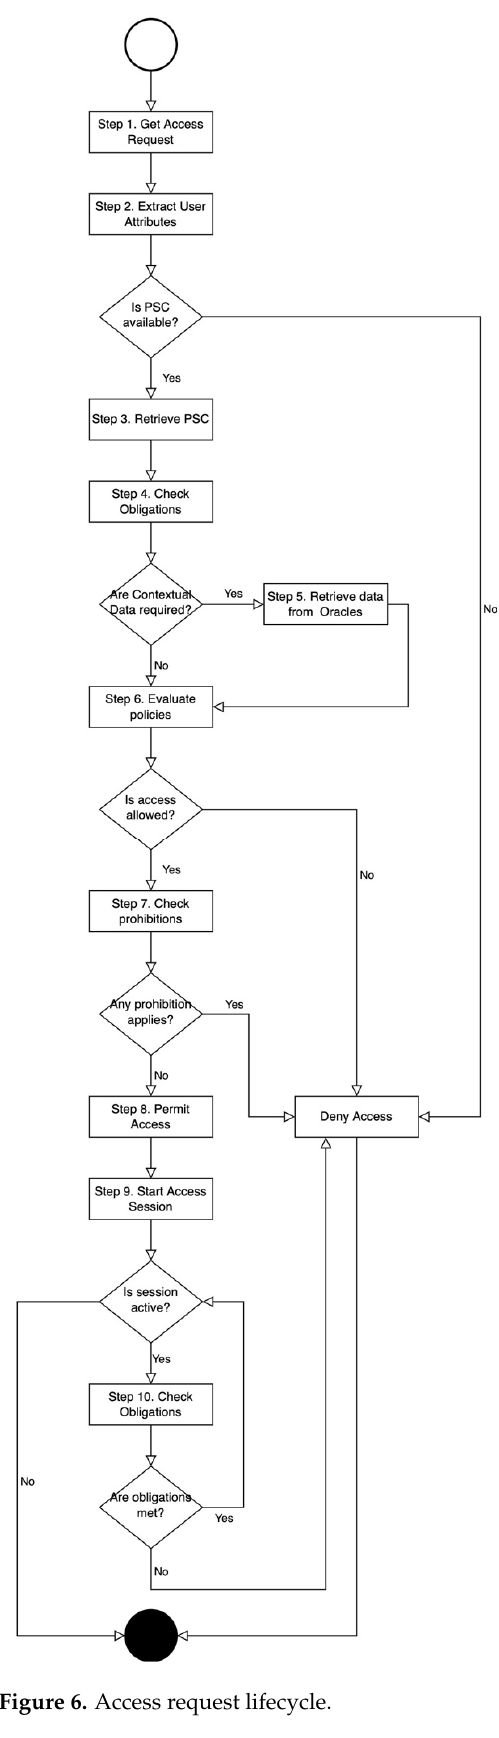
Figure 6. Access request lifecycle.